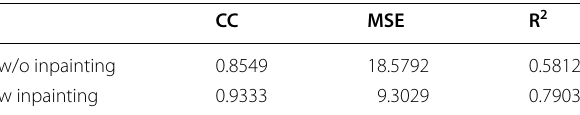
Table 5 Comparison of methods with and without inpainting in regressing CRS-R scores